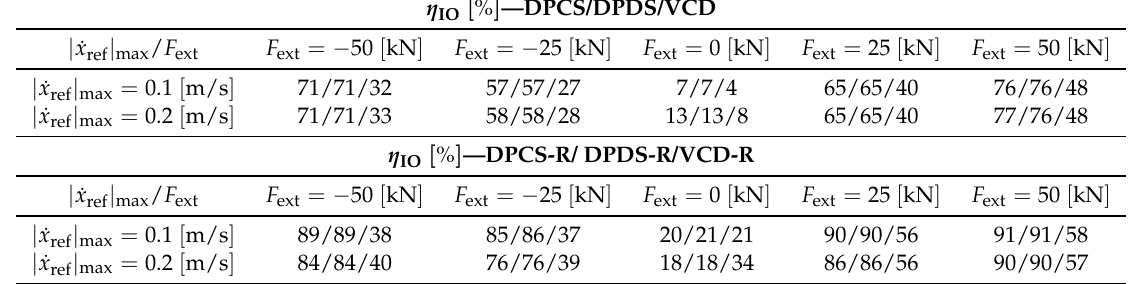
Table 3. Ratio of piston work and drive energy consumption ( η IO ).